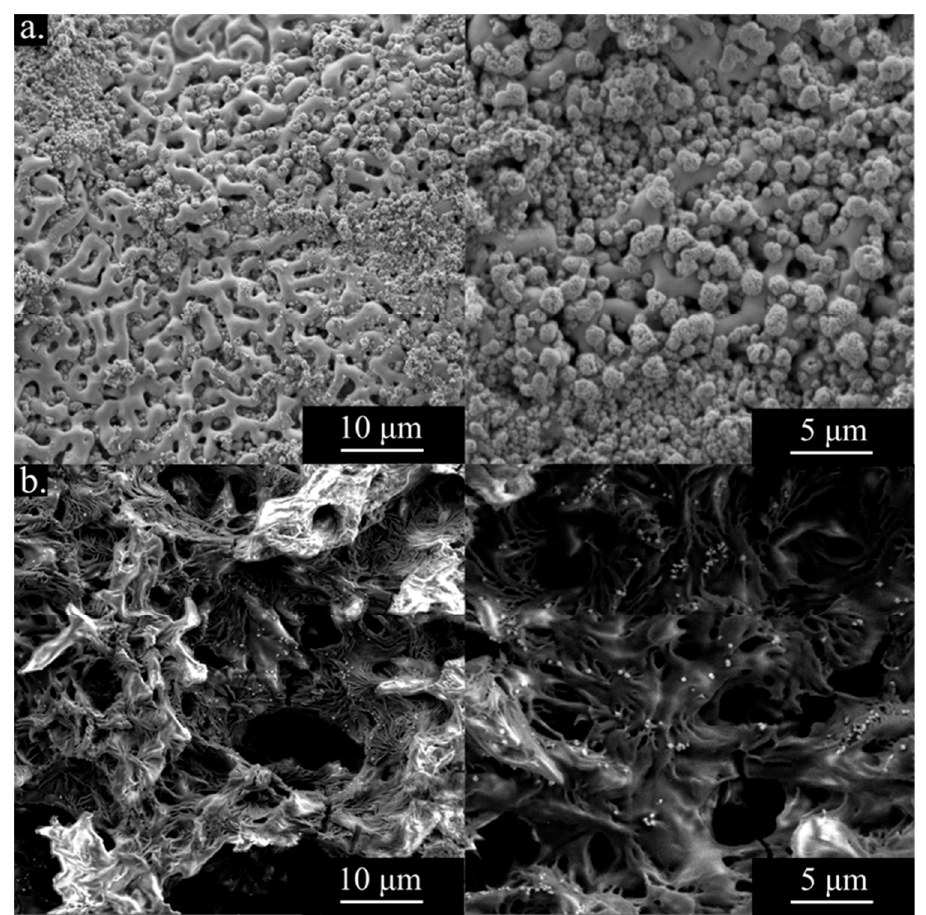
Figure 7. SEM micrographs of CP samples after surface treatment: MAO ( a ), MAO and EPD ( b ).